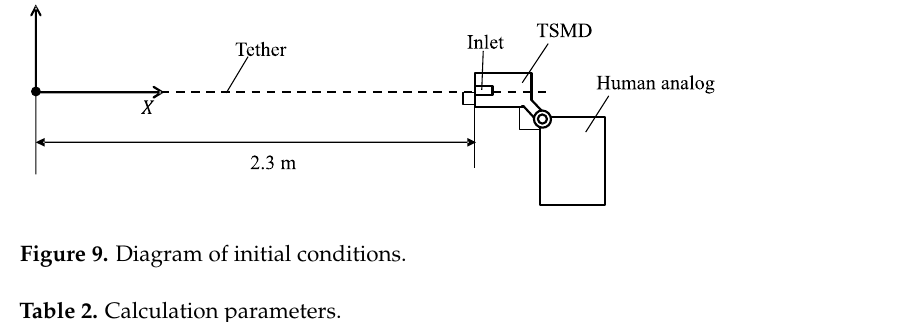
Figure 8. Types of slip shape at inlet.